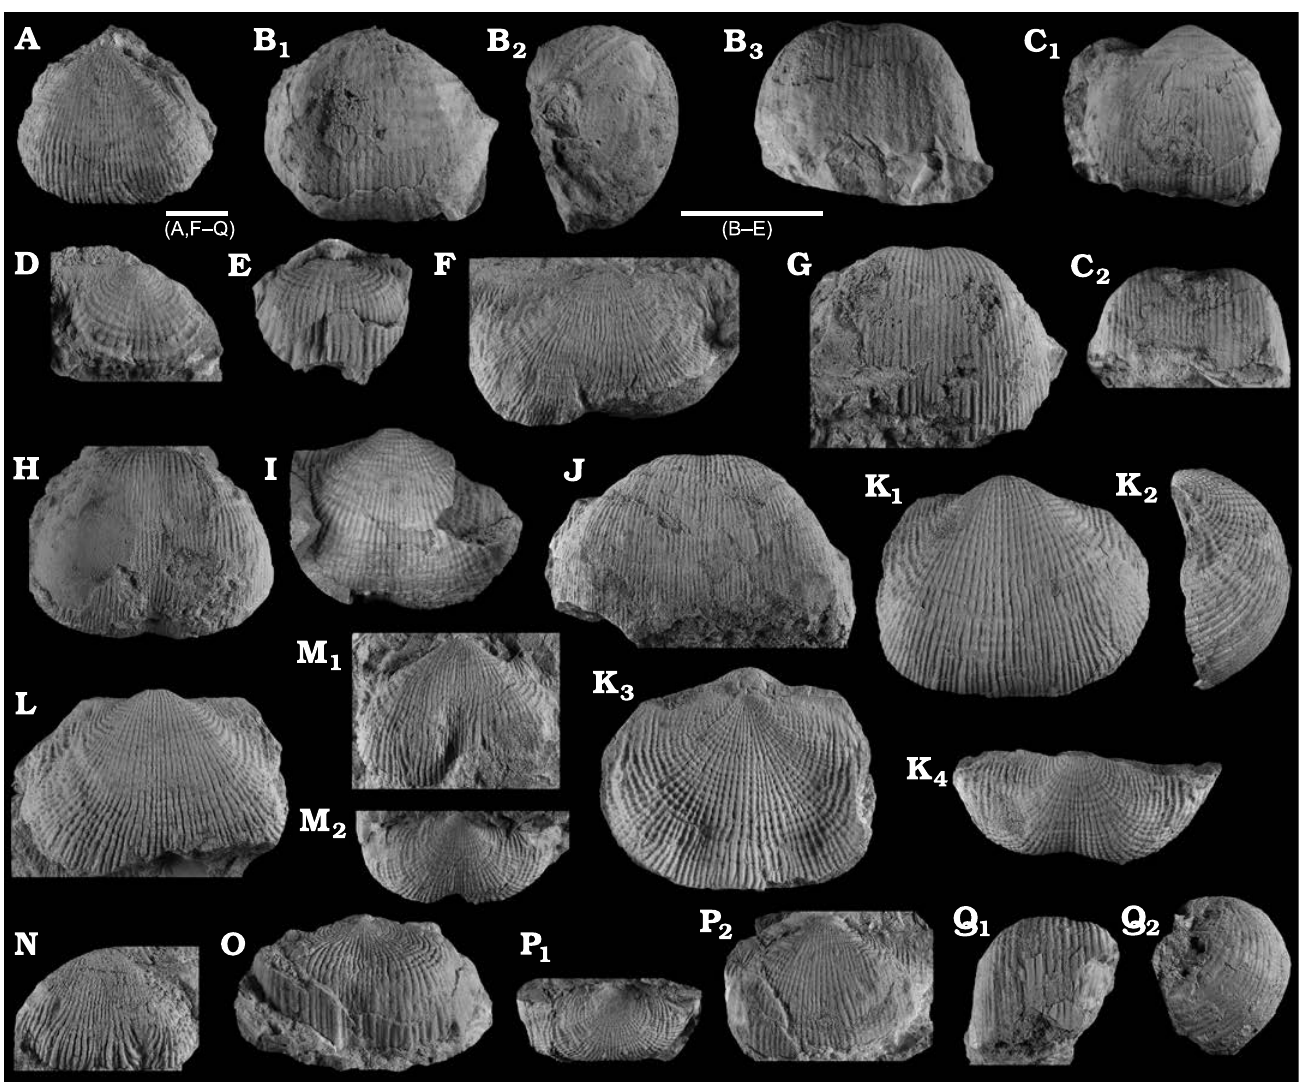
Fig. 10. Productidae from the Brigantian (uppermost Visean) of Ricklow Quarry, near Monyash (localities RCC-, RCK-; see Fig. 3) and Wensley Dale, near Matlock (locality WI1; see Fig. 2), Derbyshire, UK. A . Productus cf. productus (Martin, 1809), MPUM11919 (RCC41-3a) in ventral view. B – E . Eomarginifera cf. laqueata (Muir-Wood, 1928). B . MPUM11910 (RCC32-26) in ventral (B 1 ), lateral (B 2 ), and anterior (B 3 ) views. C . MPUM11911 (WI1-41) in ventral (C 1 ) and anterior (C 2 ) views. D . MPUM11914 (RCC60-35) dorsal valve interior and external cast. E . MPUM11915